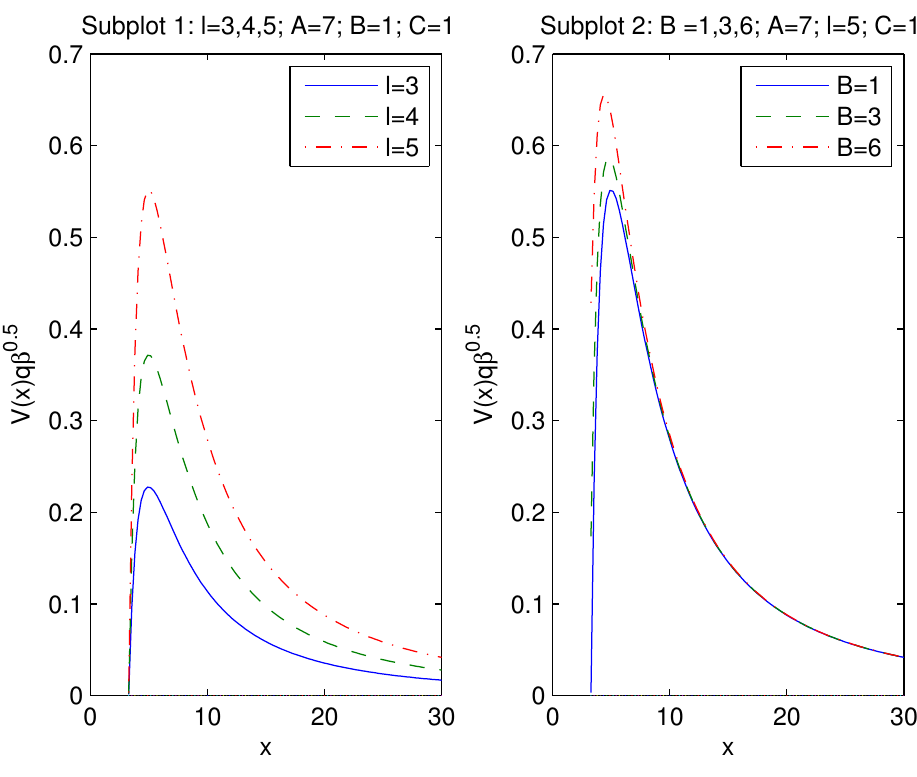
(cid:112) β q for A = 7, C = 1.